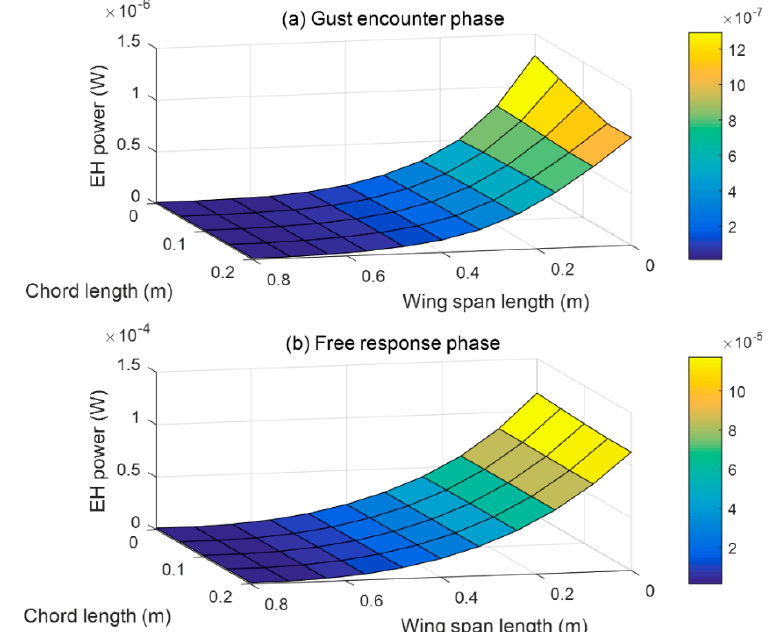
Figure 5. EH power output during ( a ) gust encounter phase; ( b ) EH power output during free response phase. Flight working condition: 40 m/s chordwise flow speed and 5 m/s “one-minus-cosine” discrete gust intensity; 100 m gust wavelength; Wing span length from the root (0 m) to the tip (0.80 m); chord length from leading edge (0 m) to trailing edge (0.20 m).